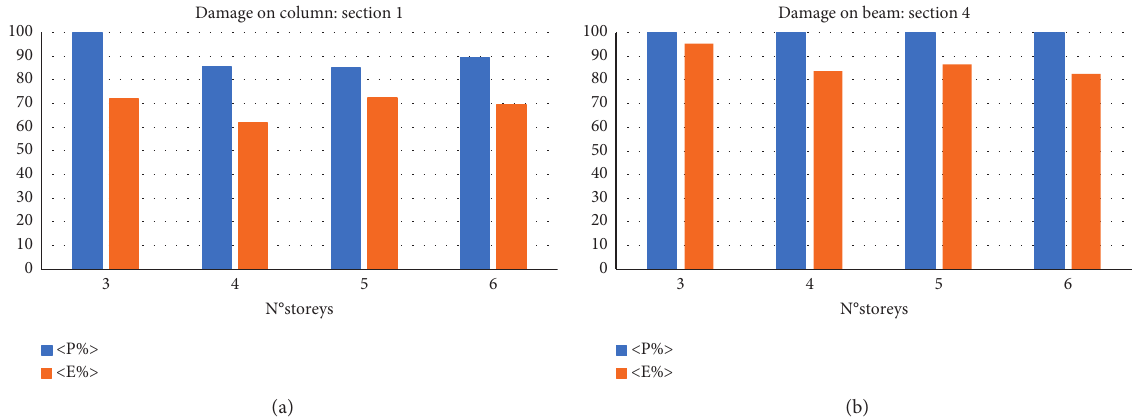
Figure 16: Mean values < P % > and < E % > calculated over the damage intensities α for increasing sizes of the frame: (a) damage location on column section 1; (b) damage location on beam section 4.